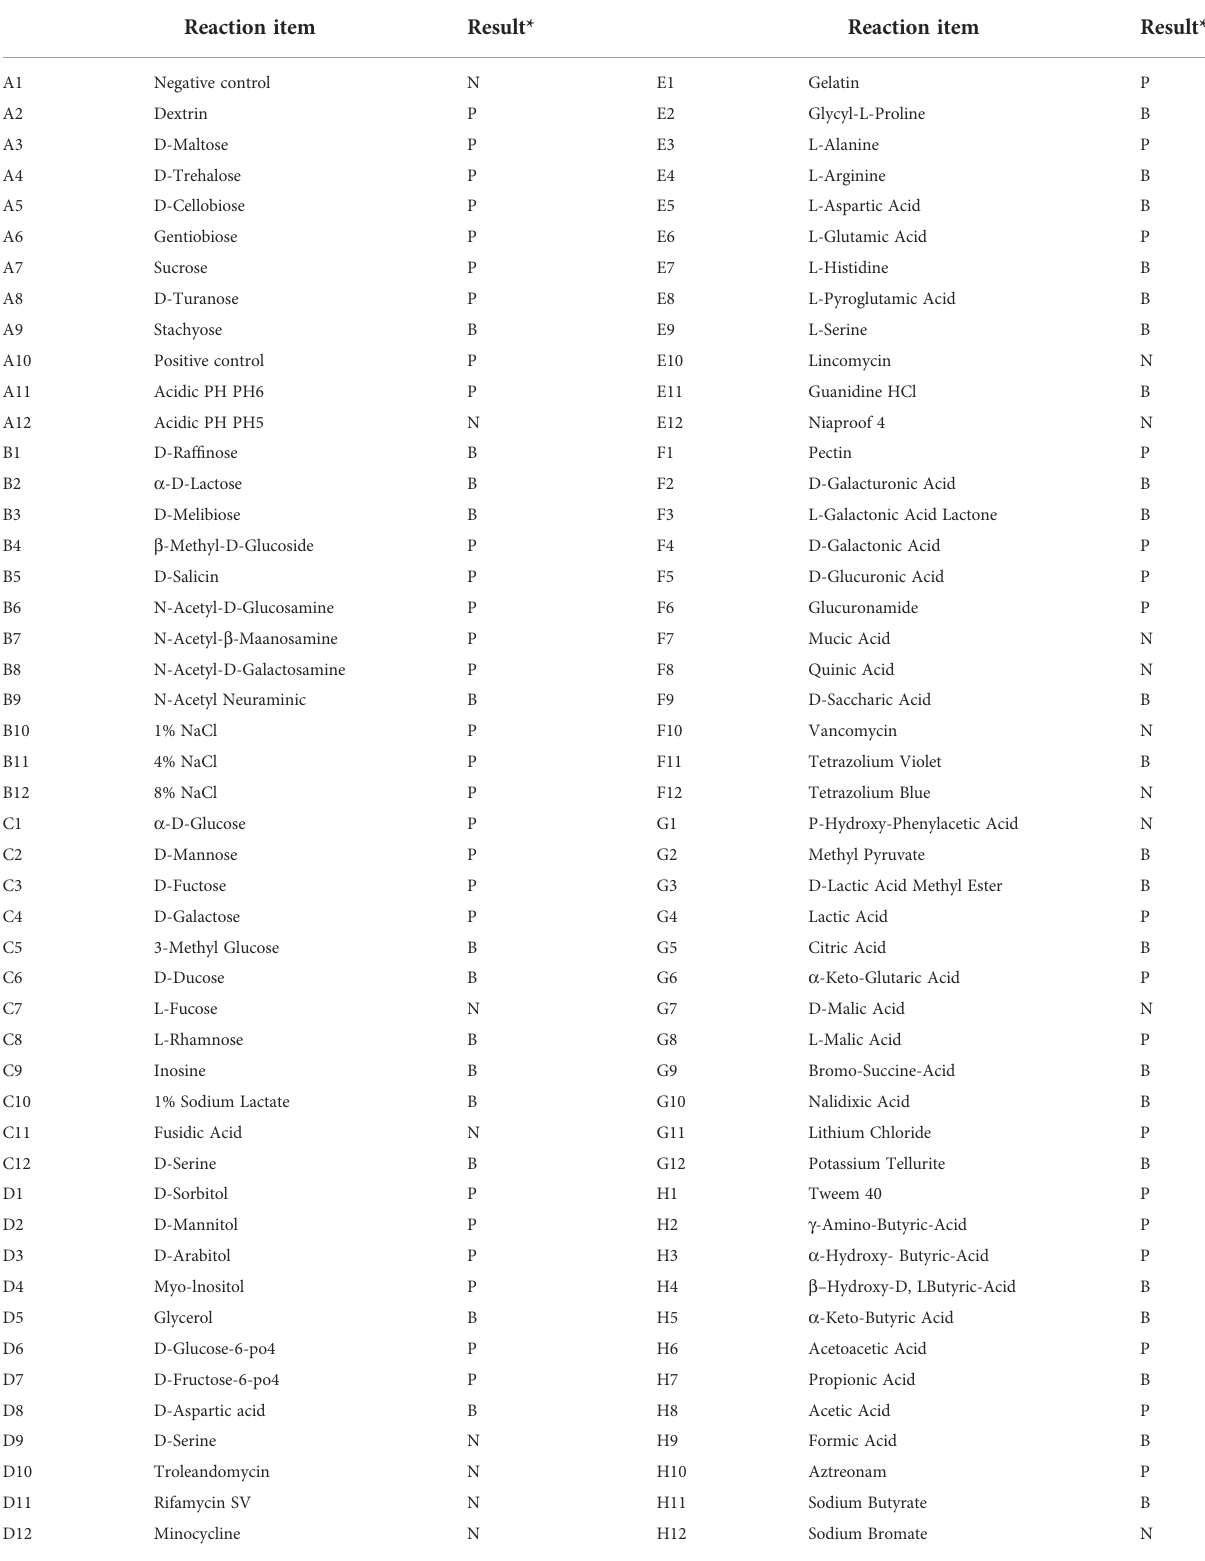
TABLE 1 Physiological and biochemical identi fi cation of